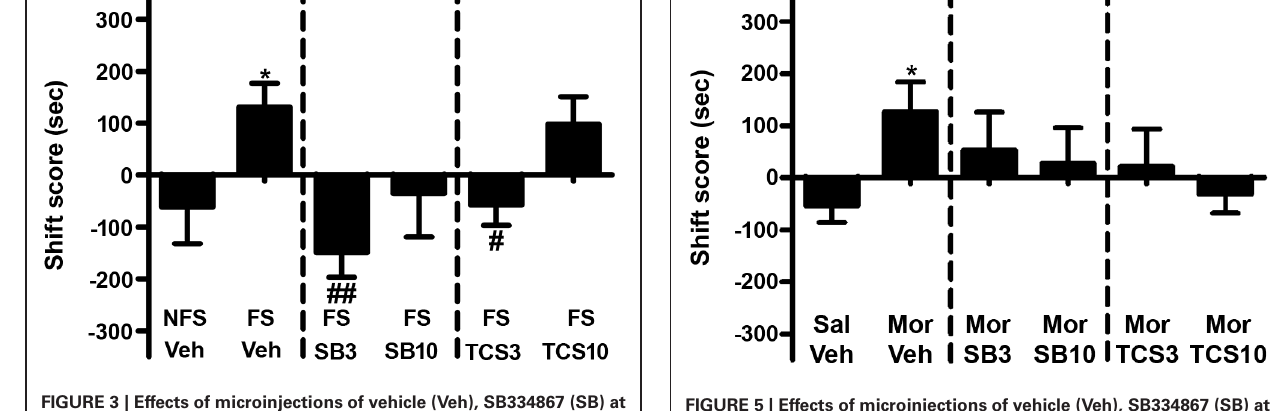
FIGURE 5 | Effects of microinjections of vehicle (Veh), SB334867 (SB) at 3.0 or 10.0 µ g (SB3 and SB10), or TCSOX229 (TCS) at 3.0 or 10.0 µ g (TCS3 and TCS10) in the NAcSh on morphine-inducedreinstatement of morphine CPP. * p < 0.05, the morphine group (Mor + Veh) compared to the control group (Sal + Veh). All data are expressed as mean ± SEM.